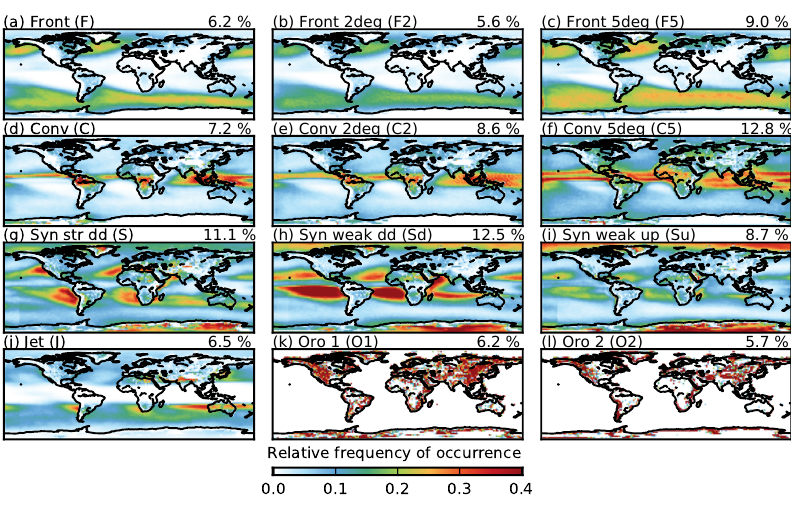
Figure 2. The relative frequency of occurrence of the different regimes over a 10-year period (2003–2013). The frequencies are normalised so that they sum to one in each grid box. The latitude weighted mean RFO for each regime is shown at the top right for each subplot.